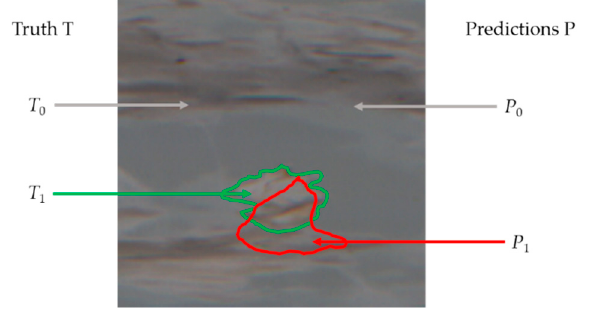
Figure 9. Ground truth and predictions.